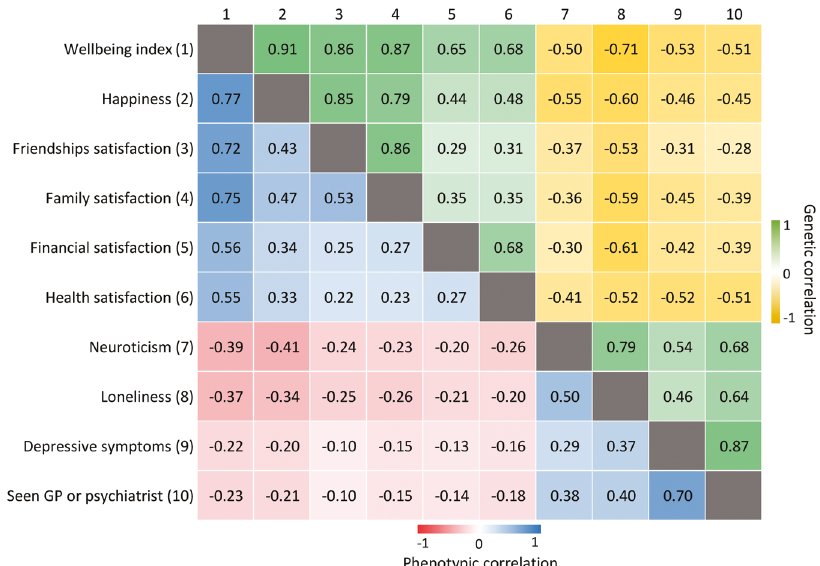
Fig. 1 Phenotypic and genetic correlations between the wellbeing index score, its subcomponents and negative mental health indicators in UK Biobank. All correlations reported here are statistically signi fi cant after Bonferroni correction for multiple testing, although many have low ( r = 0.3 – 0.5) to moderate ( r = 0.5 – 0.7) effect size. Manhattan plots for each GWAS are provided in Figure